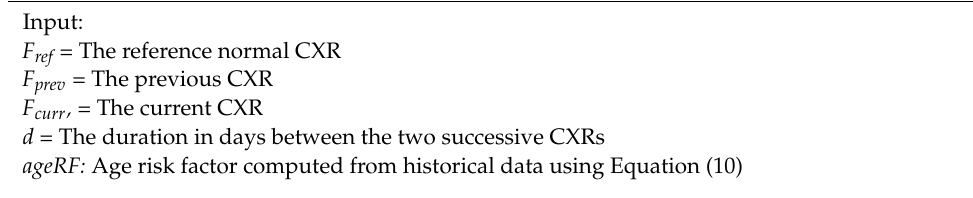
Algorithm 1: Progression Estimation